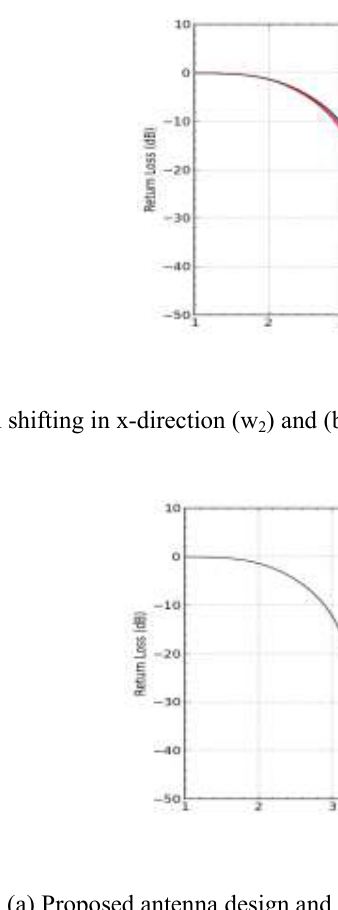
Figure 7: (a) Patch shifting in y-direction (l 2 ) and (b) its corresponding optimization results